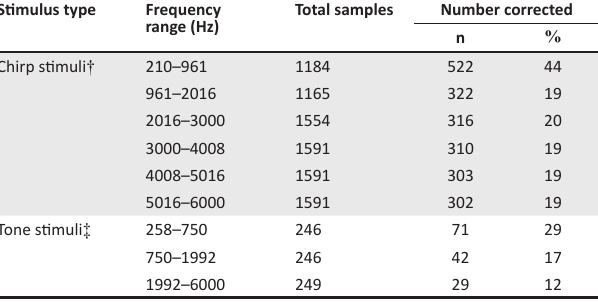
TABLE 1: Number of corrected wideband reflectance samples by using chirp and tone stimuli. Stimulus type